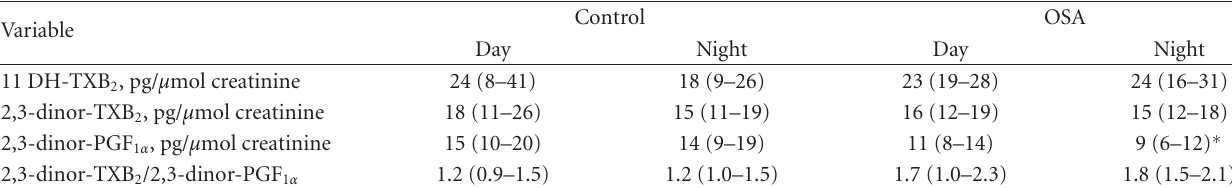
Table 3: Urinary excretion of thromboxane and prostacyclin in subjects without PFO.